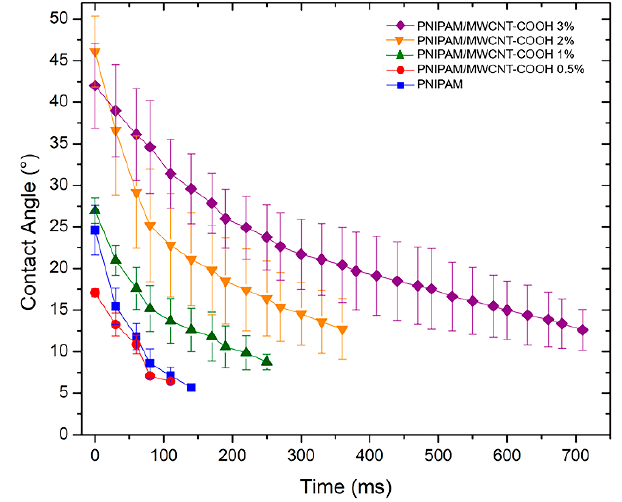
Figure 9. Time evolution of water contact angles at the surface of PNIPAM/MWCNT-COOH hydrogels with different concentrations of the carbon nanotube filler. Data measured at room temperature by optical tensiometry with values averaged over 10 replicates for each hydrogel type.